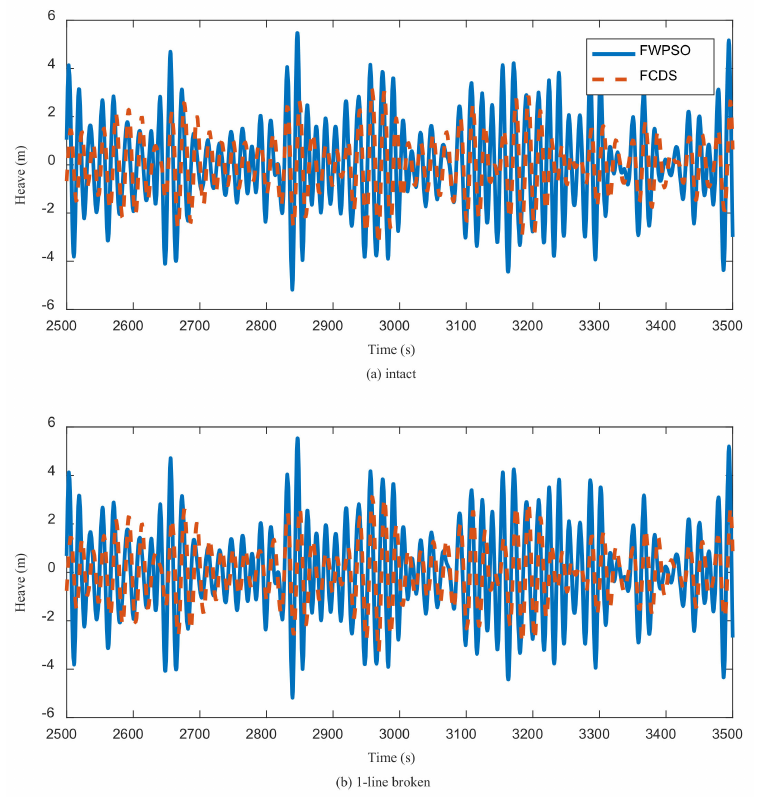
Figure 12. Time histories of the FCDS and FWPSO heave motion under both mooring line